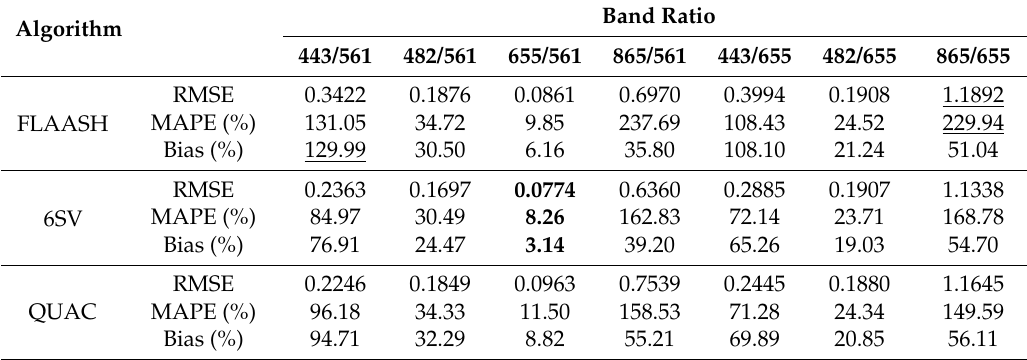
Table 6. Band ratio errors between in situ R rs and OLI R rs obtained with the land-AC algorithms. The bold means the minimal statistical value and the underline means